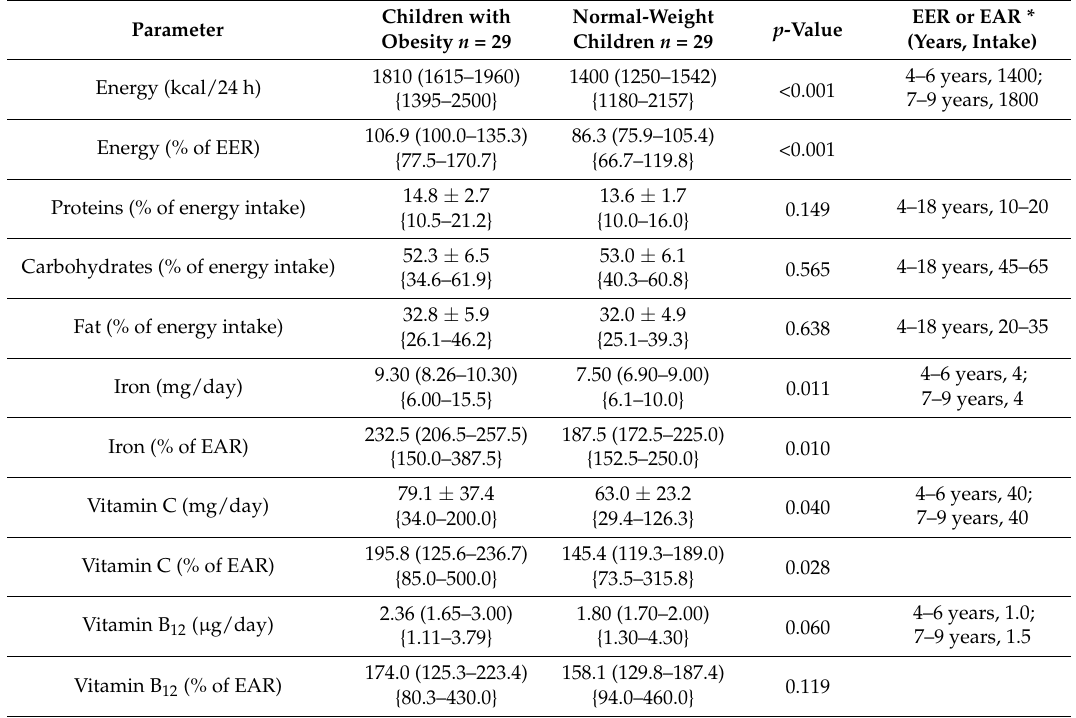
Table 4. Daily energy and nutrient intake of the examined children (pair-matched group) compared with recommended daily intake.